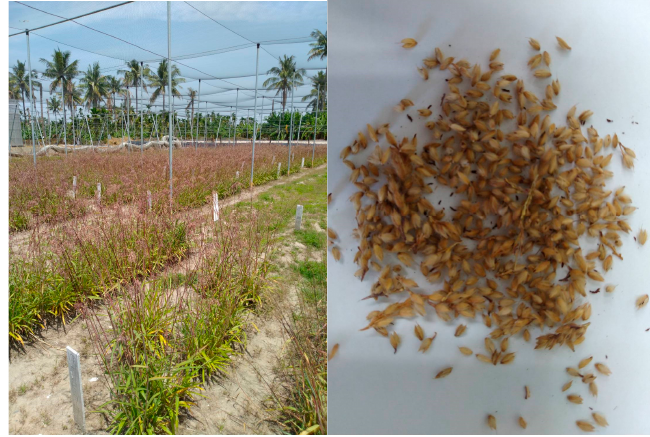
Figure 1. The appearance of Eccoilopus formosanus.